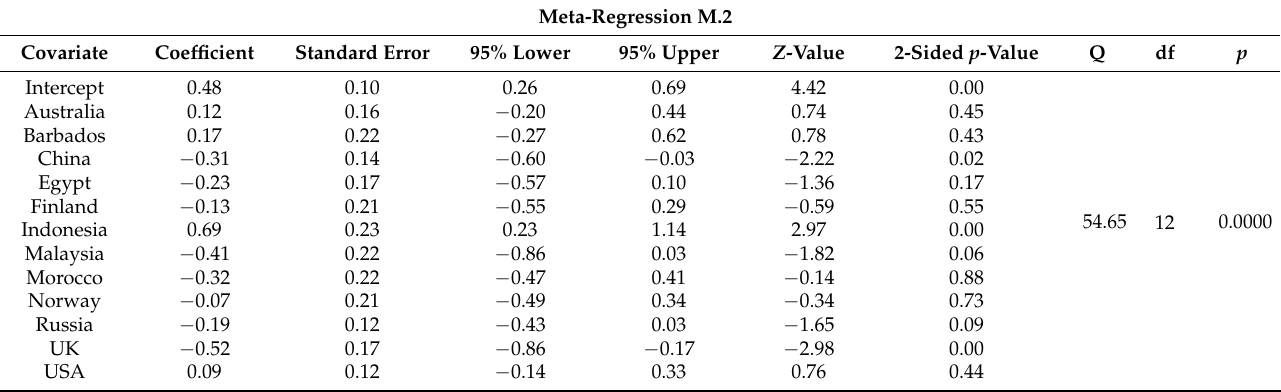
Table 4. Meta-regression of model 2: countries. Meta-Regression